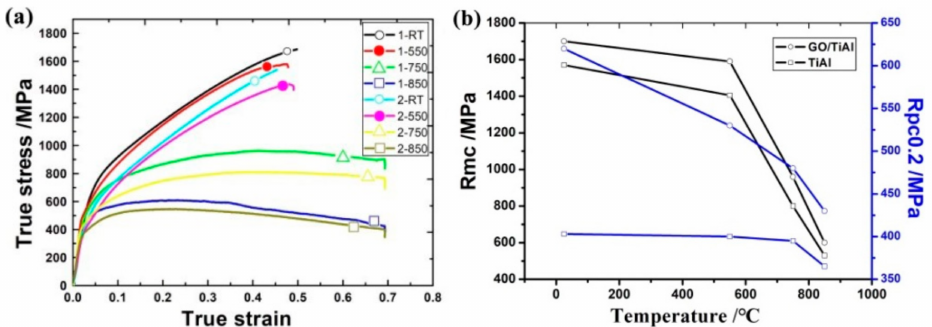
Figure 9. Compression properties of the TiAl and GO/TiAl: ( a ) true stress–true strain curve, in which No.1 is GO/TiAl and No.2 is TiAl, and ( b ) dependences of Rmc and Rpc0.2 on